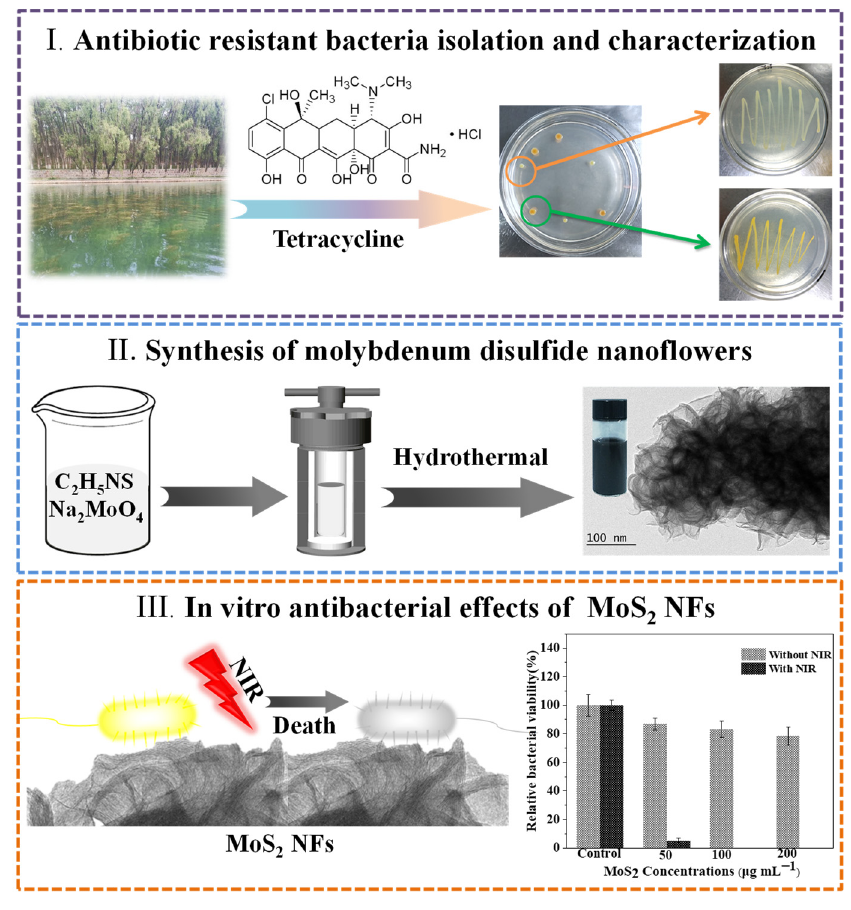
Figure 1. Schematic of PEG-MoS 2 NFs was constructed for scavenging of